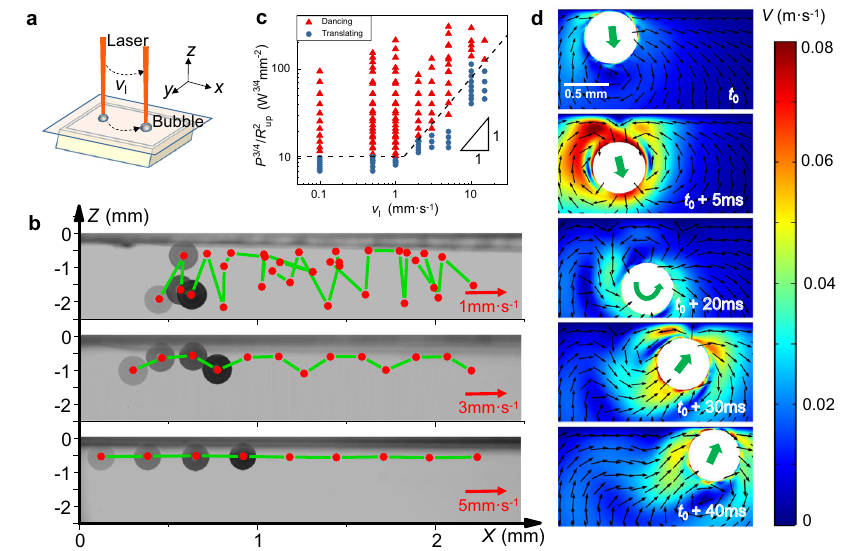
on the speed of the laser translation. d Simulation of the bubble dancing. Source data are provided as a Source Data fi